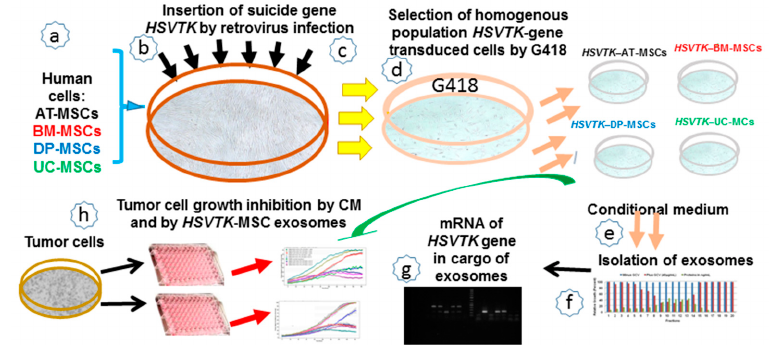
Figure 1. Steps taken during the experiment. ( a , b ) Isolation and expansion of MSCs from various tissues; ( c ) Infection of MSCs with retrovirus carrying HSVTK suicide gene; ( d ) Selection of cell population of suicide gene-transduced cells; ( e ) Harvesting of conditional medium; ( f ) Isolation of exosomes from conditional medium (CM) by size-exclusion chromatography; ( g ) Detection of mRNA of HSVTK suicide gene in the cargo of exosomes; ( h ) Tumor cell growth inhibition with CM and HSVTK -exosomes. Abbreviations: MSCs, mesenchymal stem cells; DP-MSCs, dental pulp MSCs; AT-MSCs, adipose-tissue MSCs; BM-MSCs, bone marrow MSCs; UC-MSCs, umbilical cord MSCs; HSVTK , thymidine kinase of herpes simplex virus